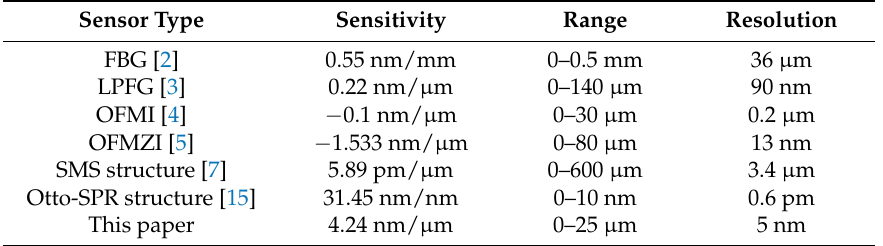
Parameter comparison between different optical-fiber micro-displacement